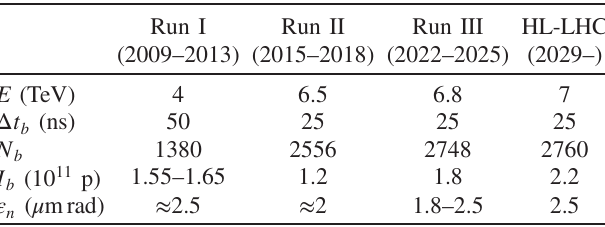
TABLE I. Proton beam parameters (beam energy E , bunch spacing Δ t b , number of bunches per beam N b , bunch intensity I b , and normalized transverse emittance ε n ) in previous and future runs of the LHC, and in the HL-LHC era. The values correspond period. Besides the standard beam production scheme,